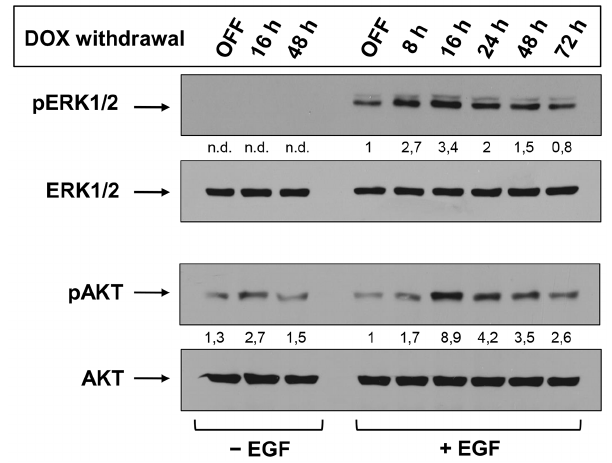
Figure 7. NEU3-HA-GFP triggers phosphorylation of ERK1/2 and Akt. OFF HeLa NEU3-HA-GFP cells were plated and switched ON for the indicated time periods. 24 h before treatment cells were grown in absence of serum. Before harvesting, cells were stimulated or not for 10 min with EGF. Cell extracts were analyzed for pERK/ERK and pAkt/ Akt by western blot using specific primary antibodies. pERK and pAkt optical densities were normalized to ERK and Akt, respectively, and values are